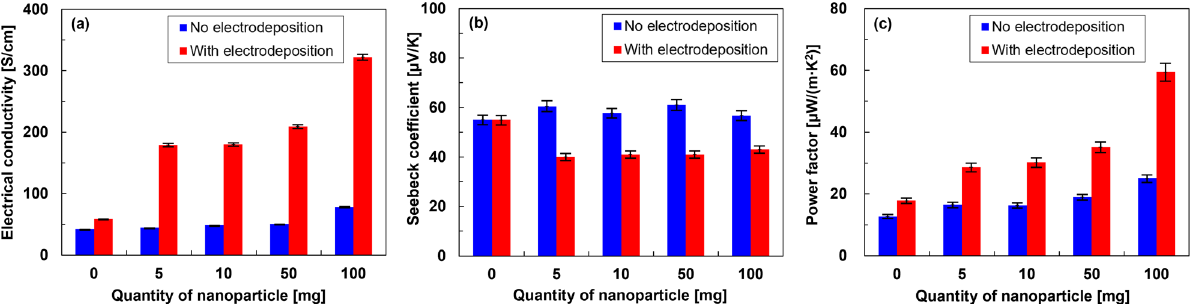
Figure 4. In-plane thermoelectric properties of SWCNT films with different quantities of nanoparticles and with electrodeposition and excluding electrodeposition. ( a ) Electrical conductivity, ( b ) Seebeck coefficient, and ( c ) power